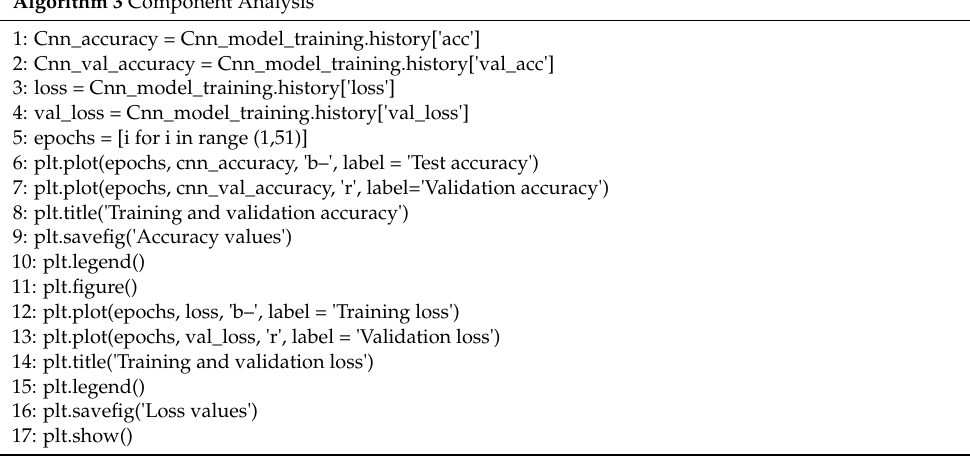
Algorithm 3 Component Analysis